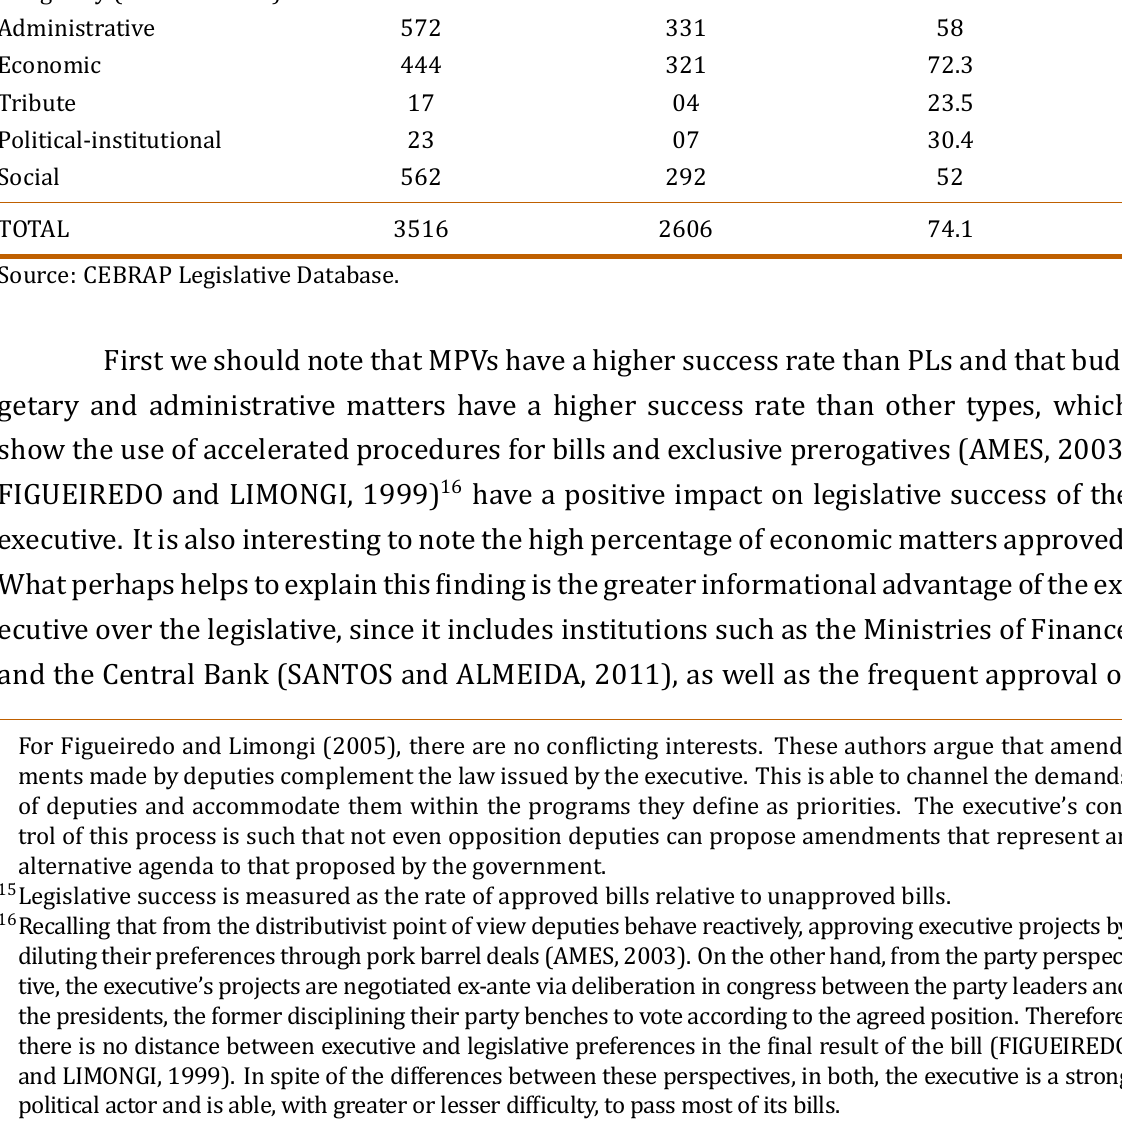
Table 2: Legislative success by type of bill (Cardoso, Lula and Rousseff) TYPE OF BILL PRESENTED APPROVED